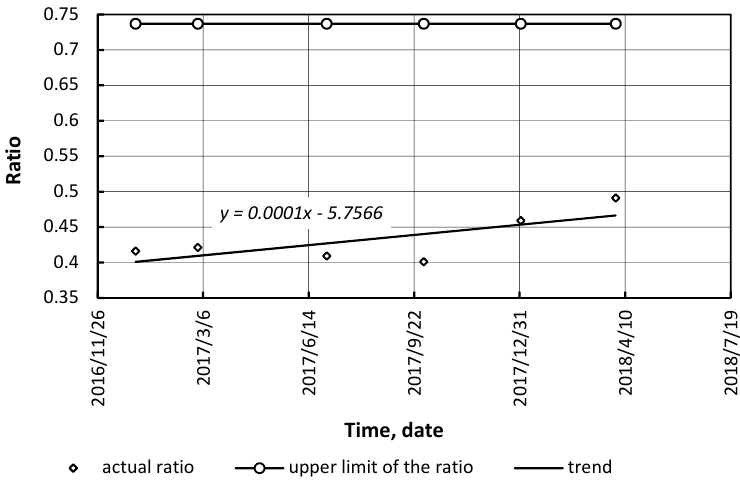
Figure 15. LPG/gasoline prices ratio in Germany.